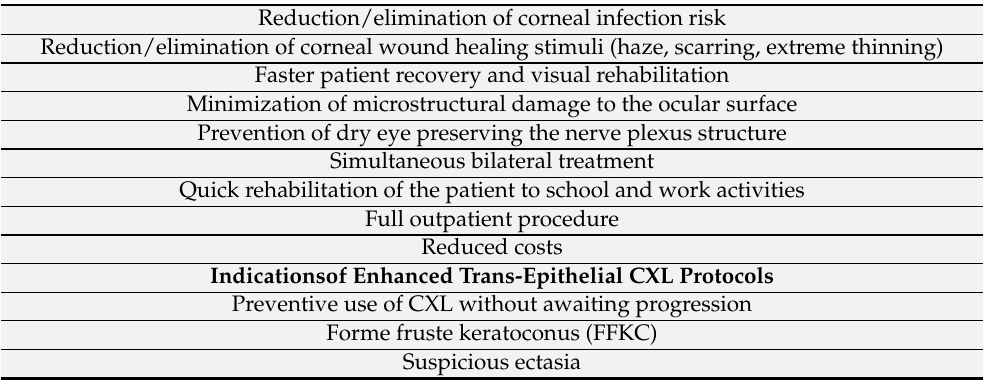
Table 3. The advantages of enhanced trans-epithelial CXL